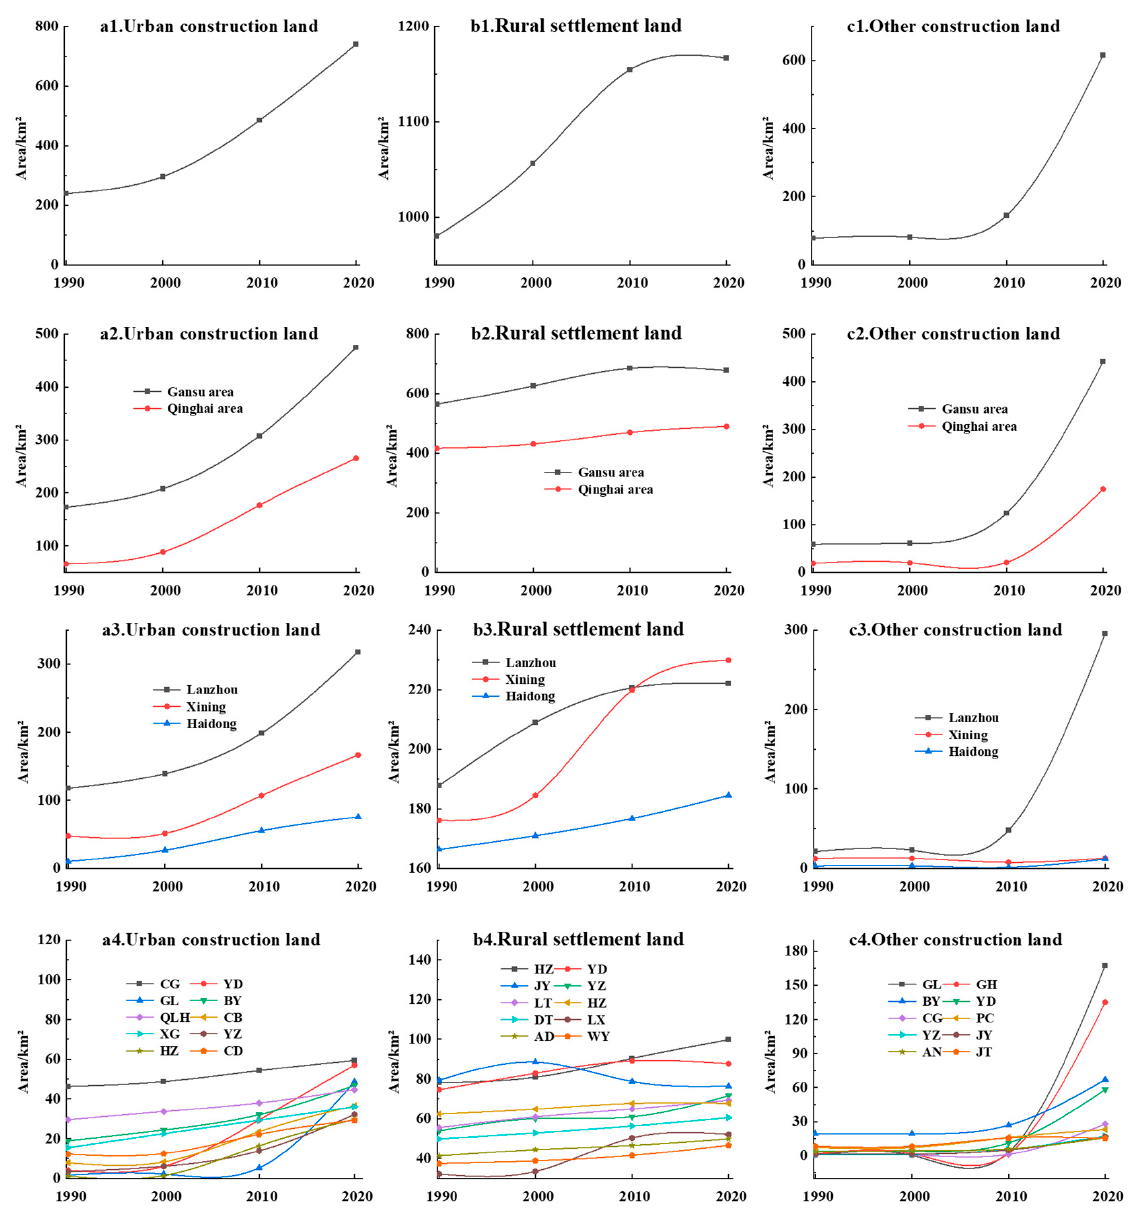
Figure 3. Multiscale areal changes in the three types of construction land in the LXUA from 1990 to 2020. Note: For clarity of the graphical expression, only the top 10 counties in terms of area in 2020 are mapped for the three types of construction land changes at the county scale.